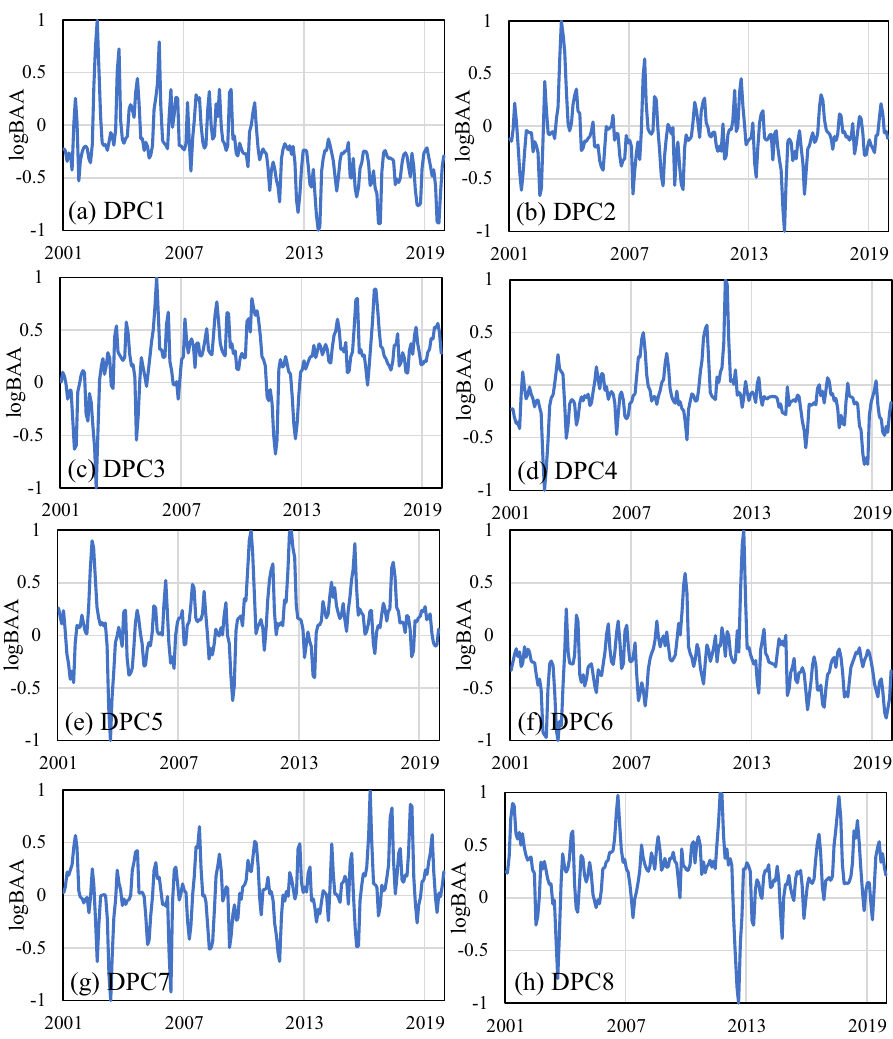
Figure 2. DPC1–8 time series of log BAA (DPCs are the projection of log BAA time series in each DEOF pattern) . The data used in the calculation comes from Fire CCI v5.1 dataset (https:// geogra. uah. es/ fire_ cci/ firec ci51.